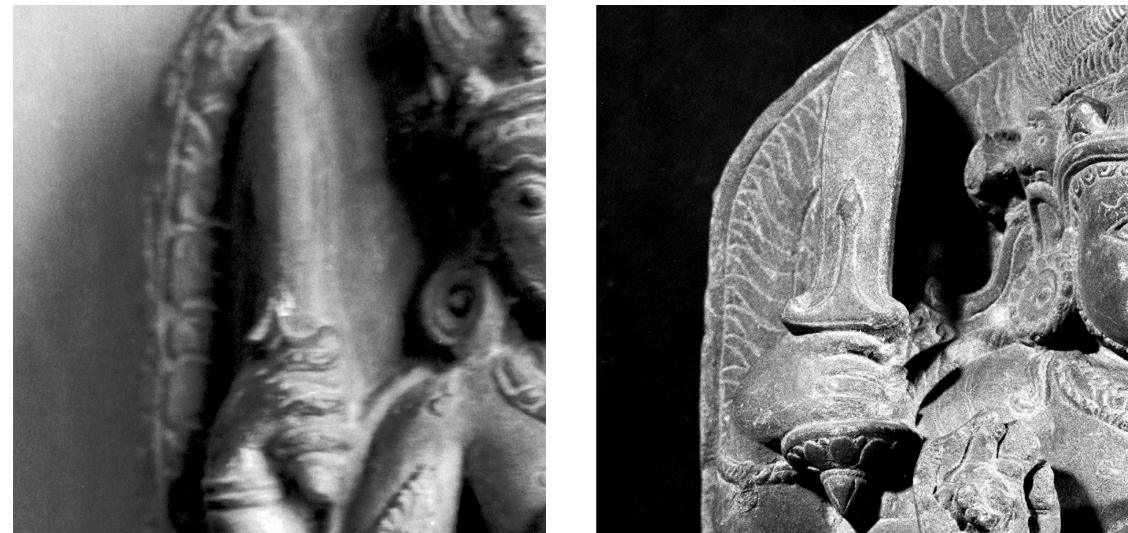
Figure 3 Two disc-pommelled swords depicted in northeastern Indian sculptures (detail). Left: Patna Museum. Right: Asutosh Museum of Indian Art. Circa 11–12th century. Courtesy of the John C. and Susan L. Huntington Photographic Archive of Buddhist and Asian Art. Scan 1979,